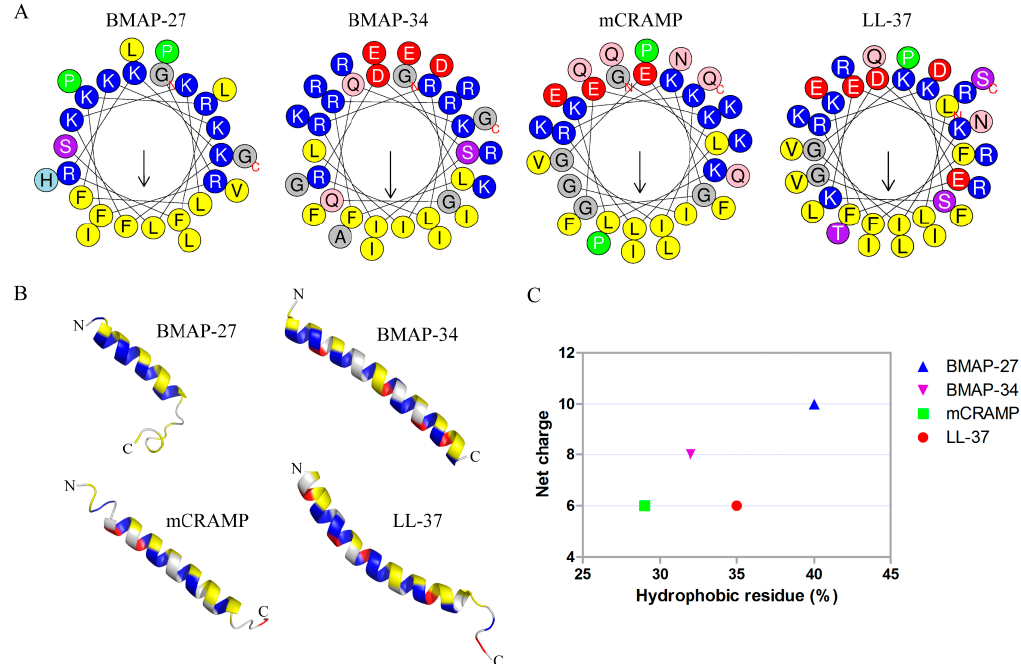
Figure 1. Structures and characteristics of mammalian cathelicidins. ( A ) Helical wheel depiction of mammalian cathelicidins. ( B ) Structures of mammalian cathelicidins. The 3D structures of BMAP-27 (PDB: 2KET) and LL-37 (PDB: 2K6O) were obtained from the Protein Data Bank. The 3D structures of BMAP-34 and mCRAMP were predicted using I-TASSER. ( C ) Values for net charge and percentage for hydrophobic amino acids of mammalian cathelicidins as obtained from the APD3 database. Int. J. Mol. Sci. 2020 , 21 , x FOR PEER REVIEW